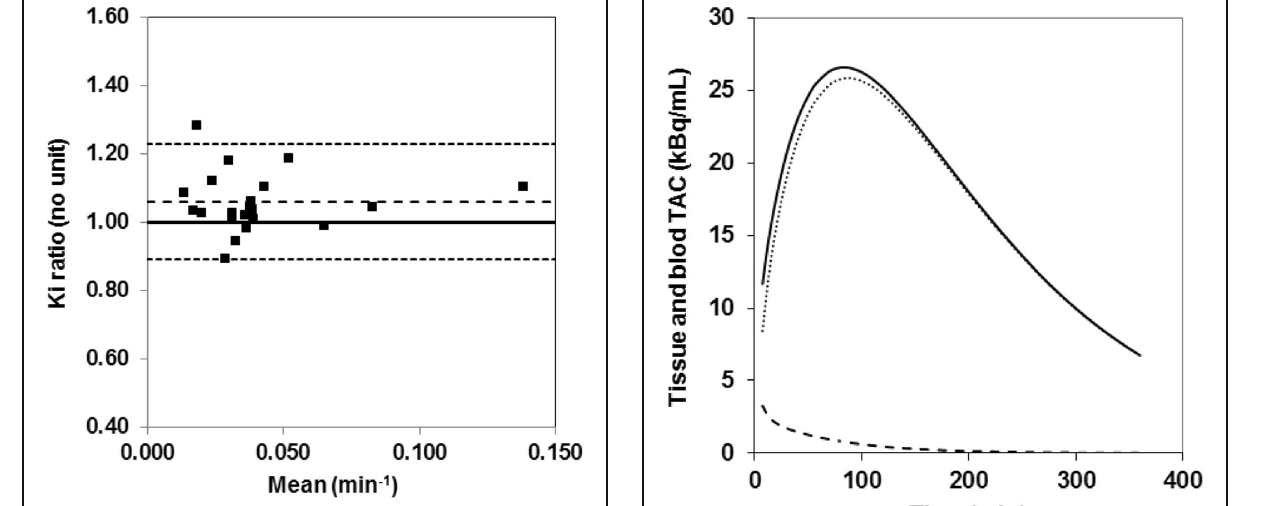
Fig. 4 Ki ratio of 3P-KMA/Patlak against mean. Ki ratio was 1.060 ± 0.040 on average (central dashed line; 95% confidence limits not shown), with 95% limits of agreement of 0.171 (upper and lower dashed lines)